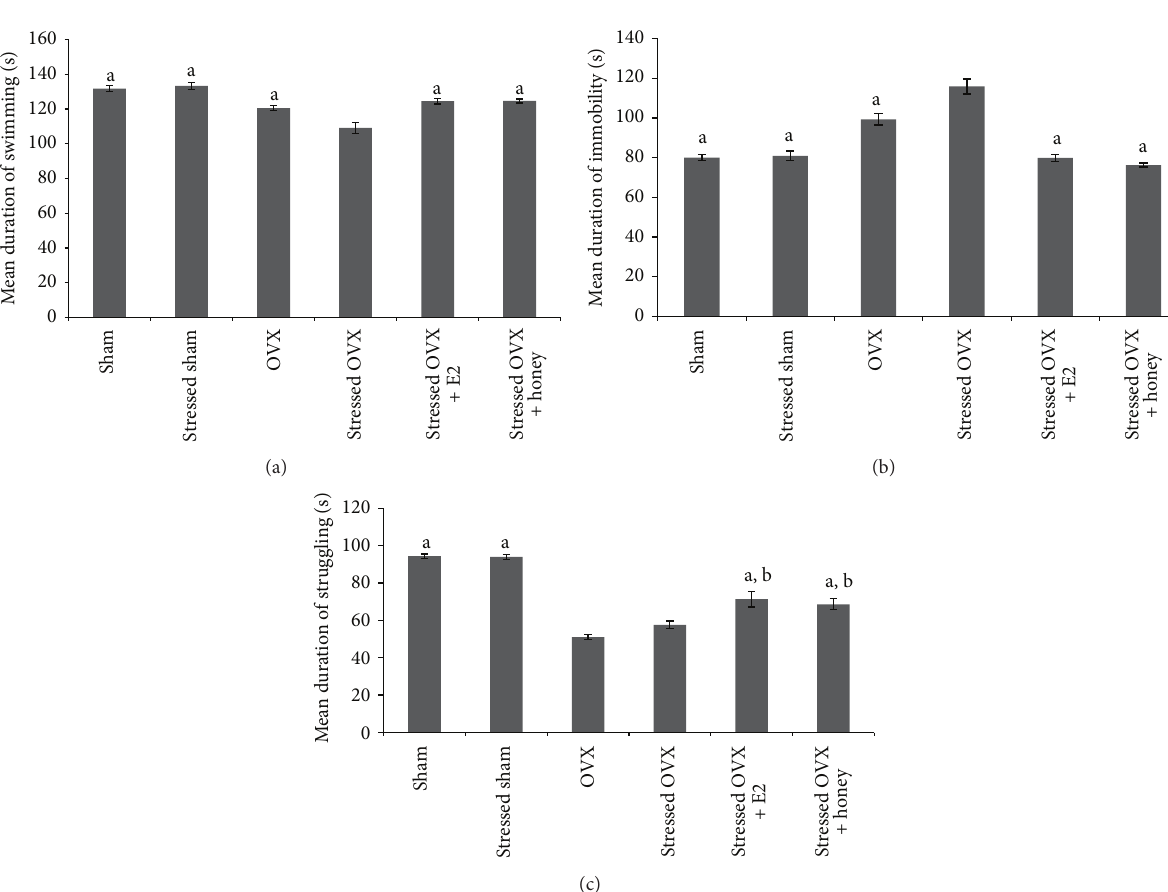
Taken together, findings from these studies suggest that the actions of estradiol in the hippocampus include regulation of BDNF. Our findings of increased BDNF concentration